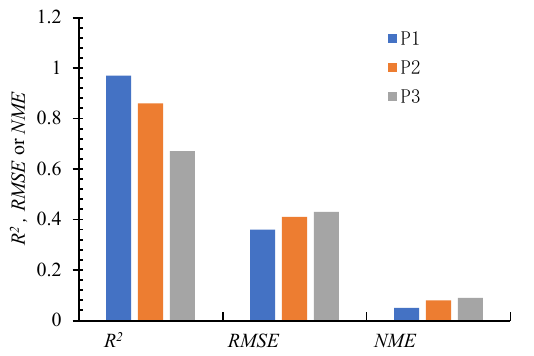
Figure 9. The R 2 (dimensionless, range from 0 to 1), RMSE (unit: g/min), and NME (dimensionless) of feed intake rate prediction at different monitoring sites using the ETR model.